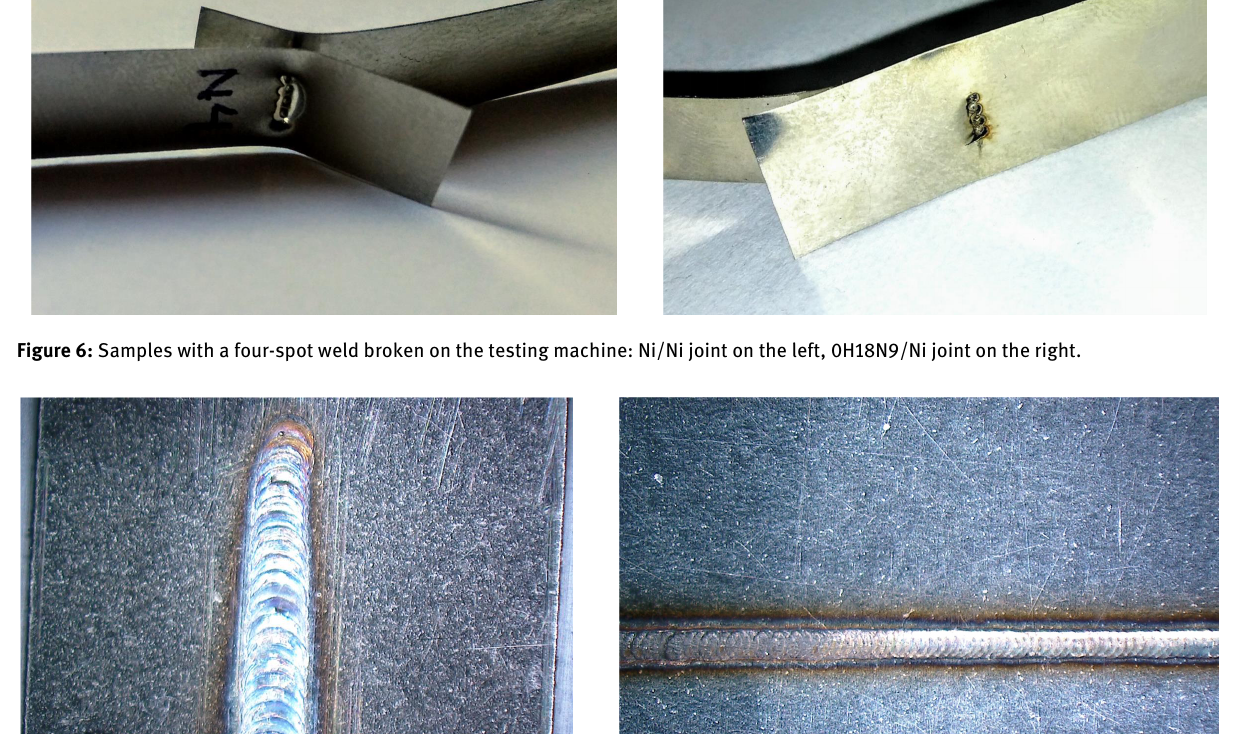
to eliminate heat impact on the material while maintain- ing defined, repeatable dimensions – when the sample was overlapped, a tensile test sample of standard dimen-